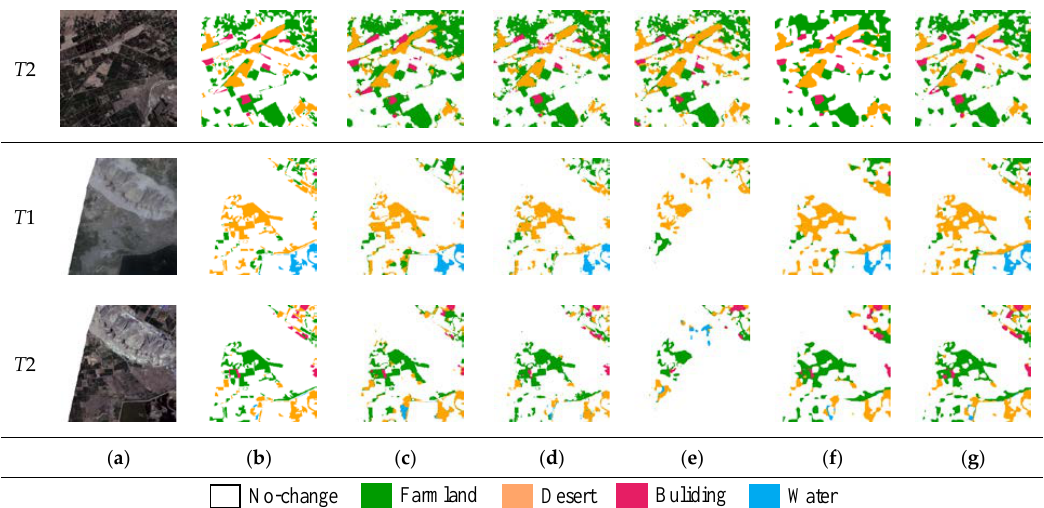
Figure 7. Comparisons of the change maps obtained by different methods on the Landsat-SCD dataset. ( a ) images, ( b ) GT, ( c ) HRSCD-str4, ( d ) BiSRNet, ( e ) FCCDN, ( f ) BIT, and ( g ) SMNet (ours).